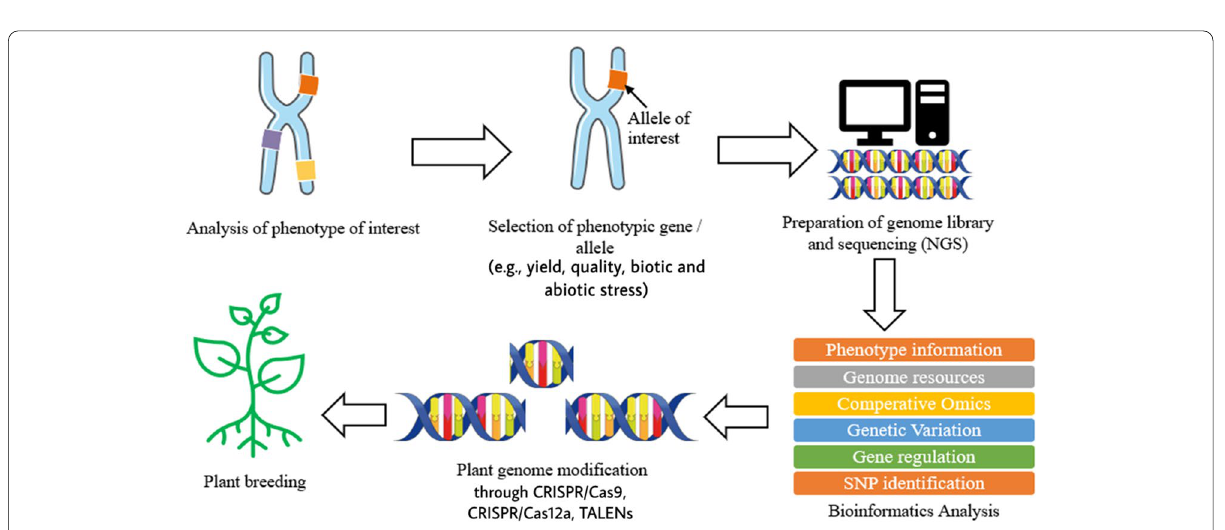
Fig. 1 Brief process of plant breeding involving NGS and